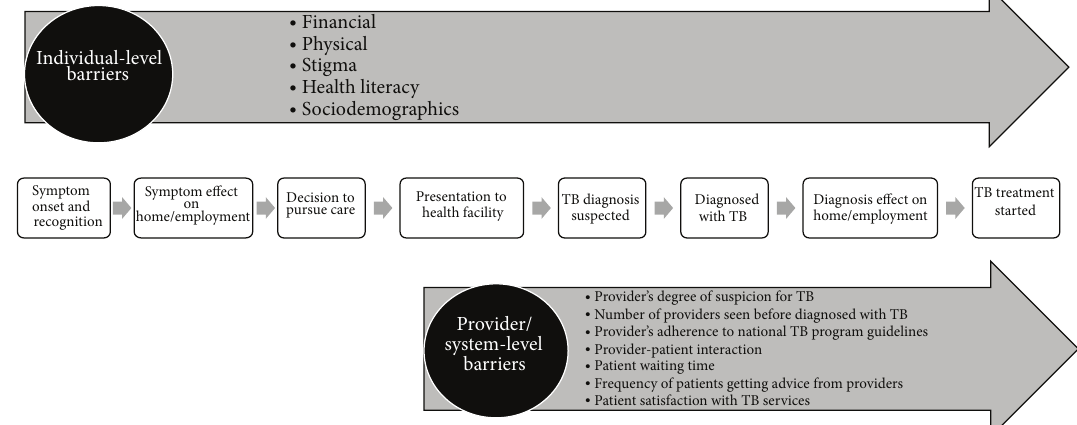
Figure 2: Conceptual framework illustrating barriers and delays that limit access to TB diagnostic and treatment services. Figure 2 illustrates the conceptual framework of the TB care continuum from symptom onset to treatment initiation that was used to define the barriers and delays that limit access to TB diagnostic and treatment services at the individual and provider/system levels. Individual-level barriers impact access to TB services along the full continuum of TB care, and the provider/system-level barriers impact TB service access from patient presentation to any health care provider through TB treatment initiation. Barriers may contribute to delays between each step along the TB care continuum. Accordingly, we define individual-level delay as the delay between symptom onset and presentation to any health care provider; provider/system delay as the delay between presentation to any health care provider and diagnosis, the delay between presentation to any health care provider and treatment initiation, or the delay between diagnosis and treatment initiation; and combined individual/provider/system delay as the delay between symptom onset and diagnosis or the delay between symptom onset and treatment